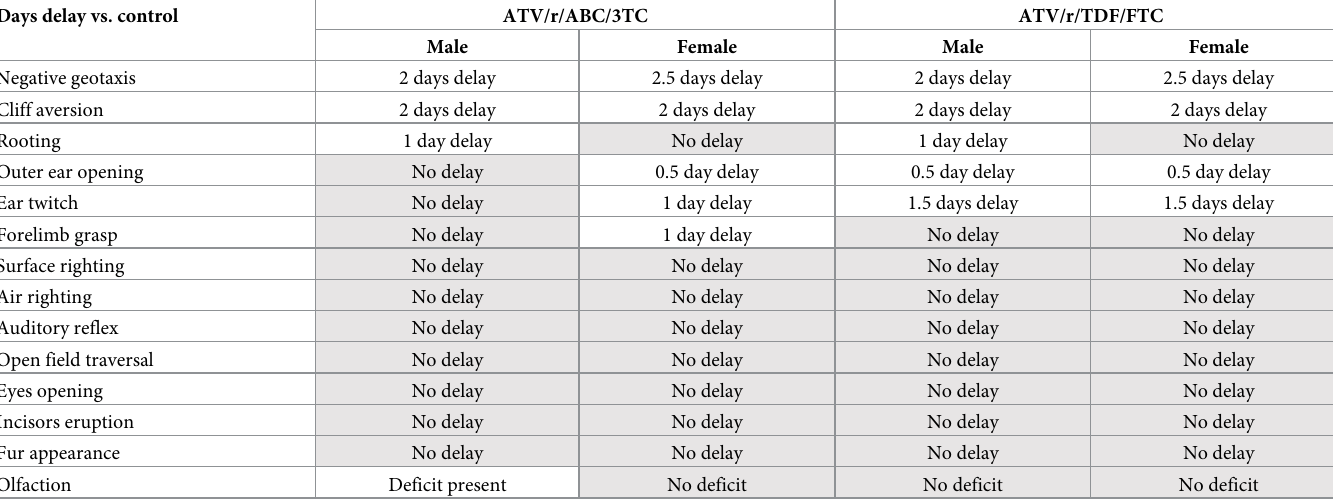
Table 1. Summary of differences in developmental milestone findings for each ART regimen compared to control. Days delay vs.